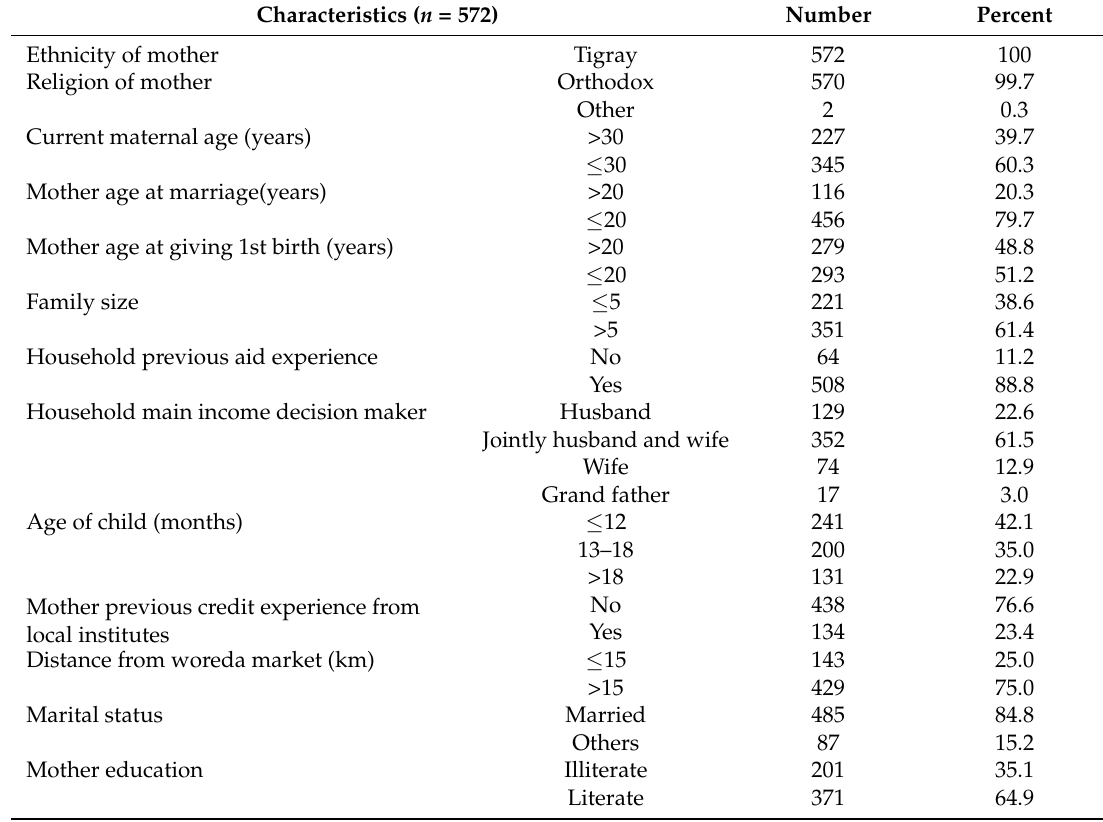
Table 1. Socio-demographic and economic characteristics of the study participants ( n = 572) in rural Tigray, Northern Ethiopia (February–June,